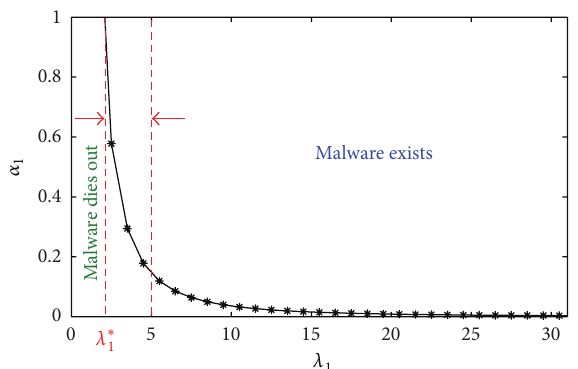
Figure 5: The relationship between 𝛼 1 and 𝜆 1 under the phase transition condition where 𝜇 1 = 0.00046 , 𝜇 2 = 0.00046 , 𝛽 1 = 0.06 , = 2 , 𝛿 = 0.06 , 𝛿 = 0.033 , 𝛼 = 0.0001 , and 𝜆 𝛽 2 1 2 2